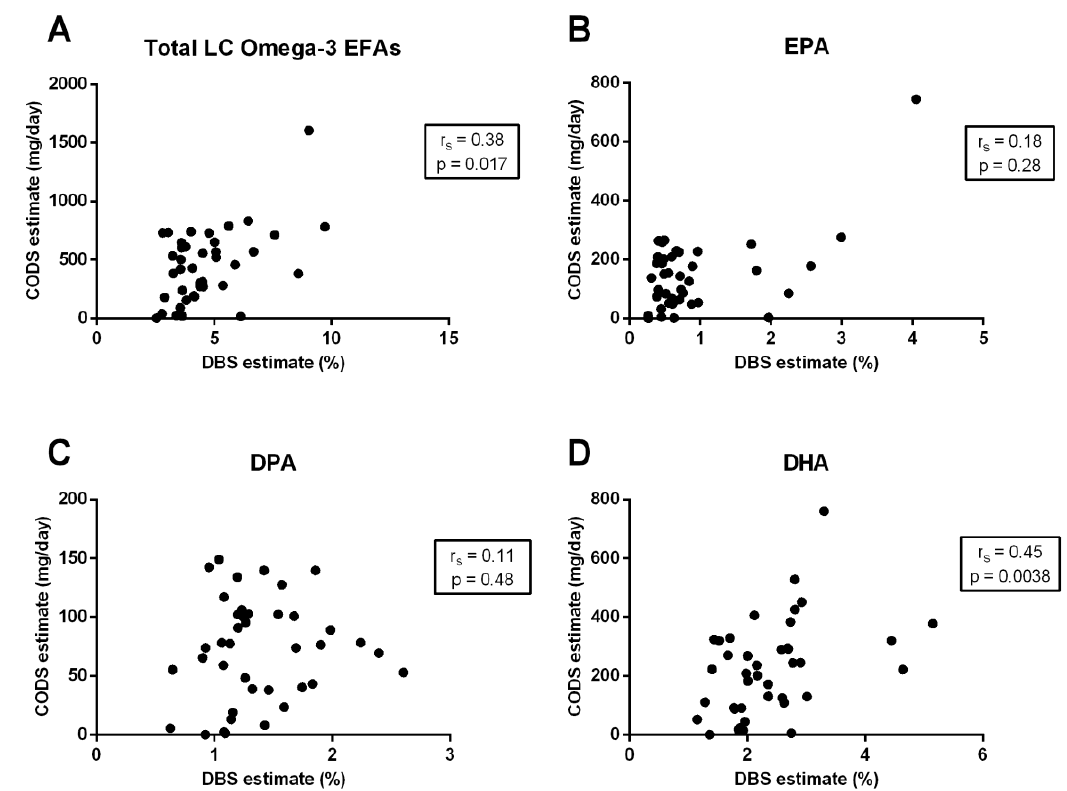
Figure 3. The relationship between total long-chain (LC) omega-3 essential fatty acids (EFAs) percentage (%) present in erythrocytes, measured using dried blood spot (DBS) biomarkers, and the dietary LC omega-3 EFA intake estimated using the Clinical Omega-3 Dietary Survey (CODS) for ( A ) total LC omega-3 EFAs, ( B ) eicosapentaenoic acid (EPA), ( C ) docosapentaenoic acid (DPA), and ( D ) docosahexaenoic acid (DHA). Correlation coefficients are calculated using the Spearman’s correlation coefficients (r s ).